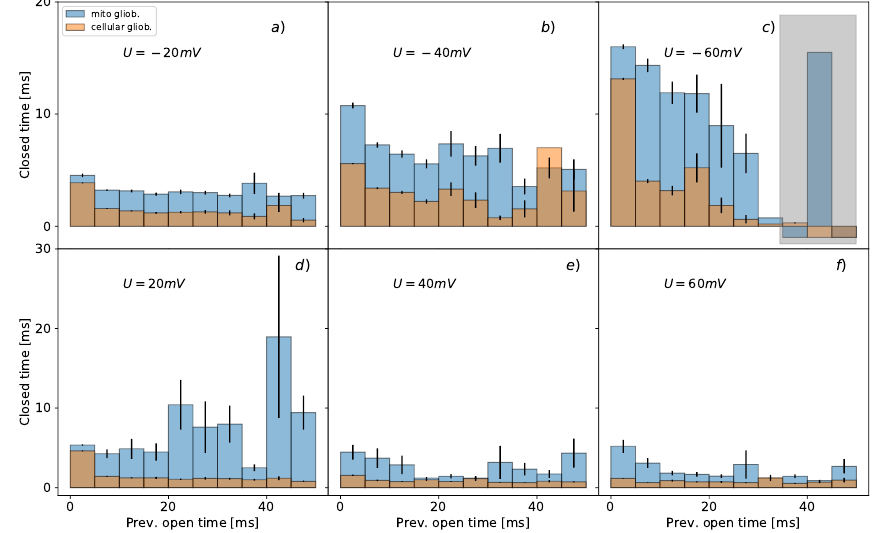
Figure 3. Mean conditional dwell-times of closed states presented with error bars representing the corresponding standard deviations. The blue bars characterize the conditional mean dwell-times for mitochondrial channels; the orange bars are assigned to the data describing BK channels from plasma membrane. The upper panels ( a – c ) present the results obtained at membrane hyperpolarization; the lower graphs ( d – f ) correspond to channel characteristics at membrane depolarization. The durations of closed states taking the value − 1 (see gray rectangle) are assigned when a given previous length of open dwell-time was not recorded within a whole population of channel